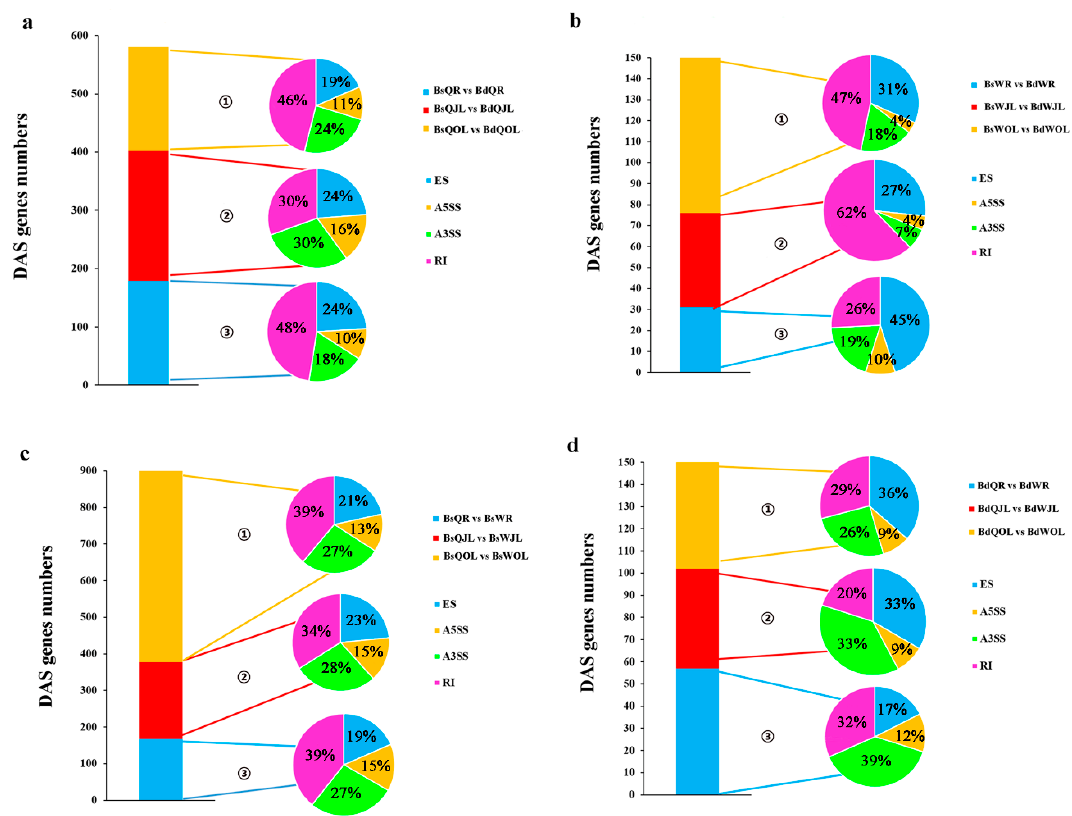
Figure 9. The number of DAS genes in the root, juvenile leaves and old leaves of B. napus cultivars Qingyou10 (QY10) and Westar10 (W10) under boron deficient conditions: ( a , b ) the total number of DAS genes (control, B sufficient condition) identified in QY10 and W10, respectively; and ( c , d ), the total number of DAS genes in QY10 (control, W10) under boron sufficient and deficient conditions, respectively. ① Ratio of four alternative splicing patterns in old leaves; ② ratio of four alternative splicing patterns in juvenile leaves; and ③ ratio of four alternative splicing patterns in root. DAS, differential alternative splicing; Bs, boron sufficient condition; Bd, boron deficient condition; QR, root of QY10; QOL, old leaves of QY10; QJL, juvenile leaves of QY10; WR, root of W10; WOL, old leaves of W10; WJL, juvenile leaves of W10. A3SS, Alternative 3 (cid:48) splice site; A5SS, alternative 5 (cid:48) splice site; RI, retain intron; ES, exon